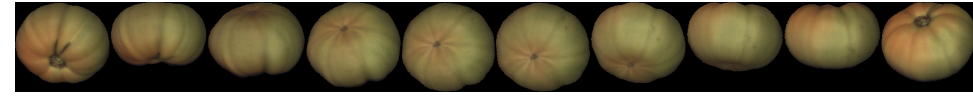
Figure 3. Set of views of the fruit highlighted in Figure 2.